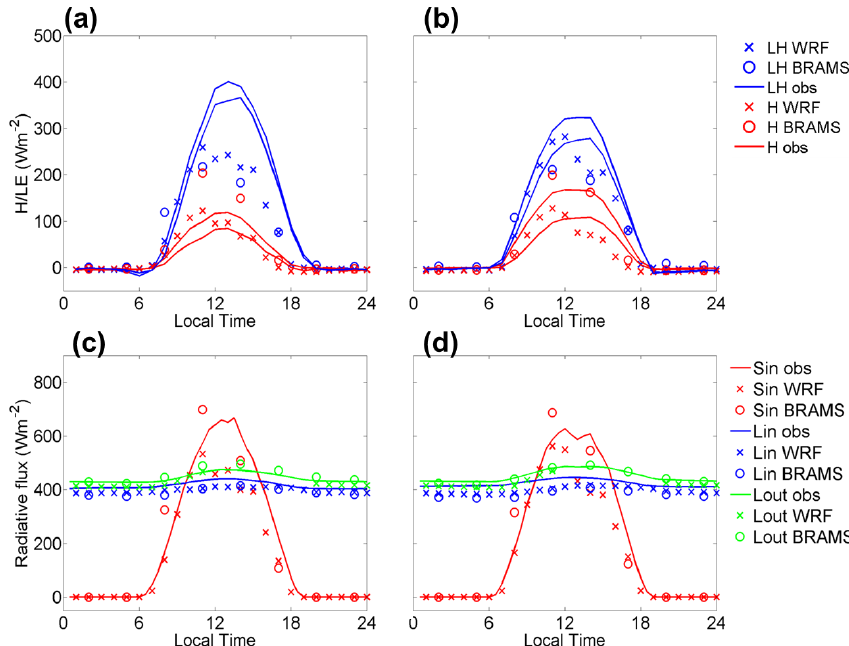
Figure 7. Mean daily cycles of surface (a) latent (LE) and sensible (H) heat and (c) incident shortwave (S in ) and incoming (L in ) and outgoing (L out ) longwave radiation fluxes for a forest site and (b) heat and (d) radiation fluxes for a pasture site, comparing observations (solid lines) from von Randow et al. (2004) for the wet-to-dry transition season (February–March 1999, January–March 2000) and from WRF-Chem (crosses) and CCATT-BRAMS (circles) for the BARCA B period (April–May